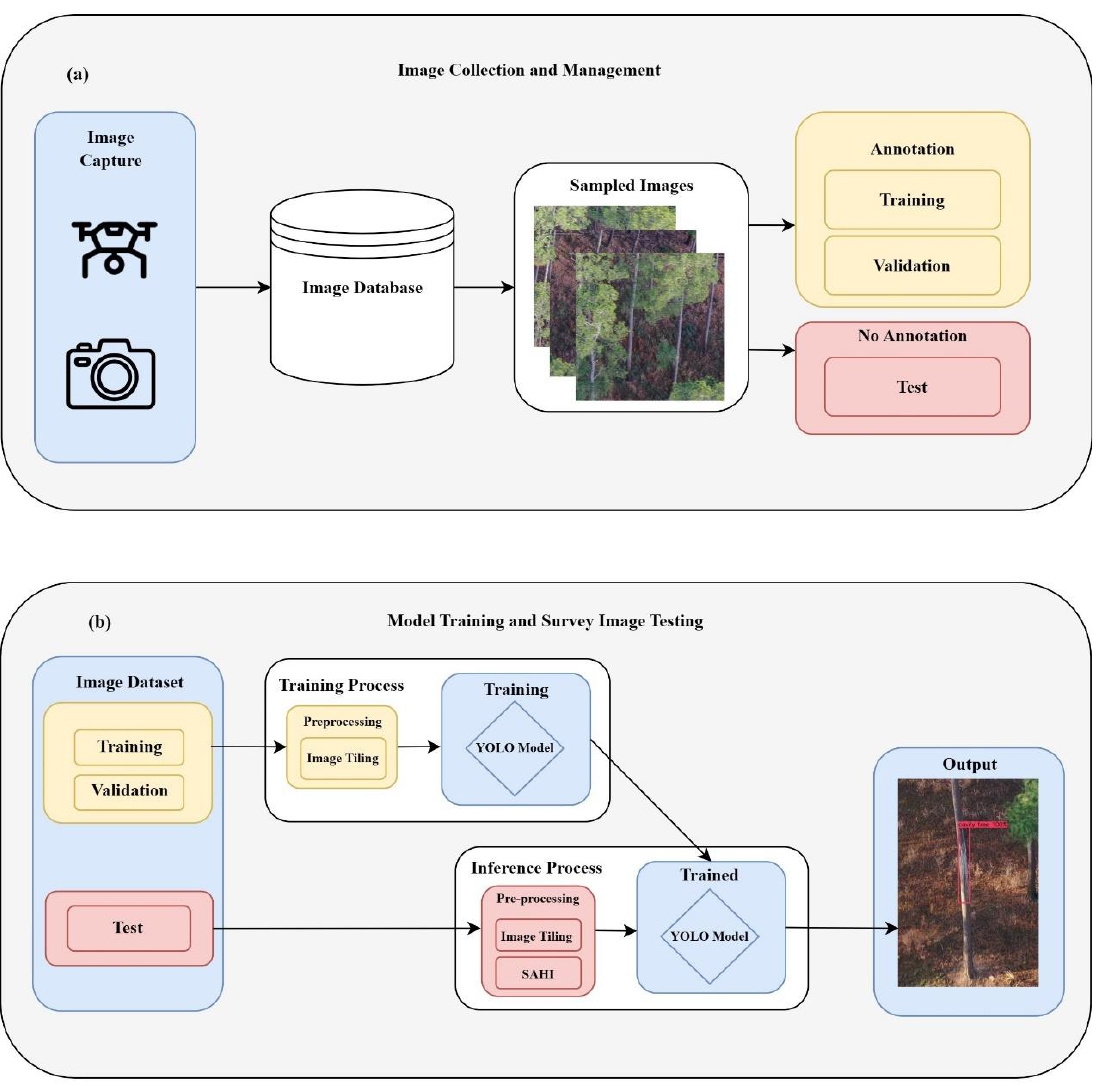
Figure 4. The entire workflow of our model development, which consists of ( a ) image collection and management and ( b ) model training and survey image testing. Both YOLOv4-tiny and YOLOv5n were used for model training because of their fast detection or inference times and to allow for comparisons between the two YOLO versions. Tiling was used for both the models for training, while tiling was used for YOLOv4-tiny and SAHI for YOLOv5n for model inferencing. However, YOLO models require specific input image sizes that are much smaller than our original, large-resolution parent images. Compressing parent images down to input dimensions would cause loss of pixels and diminish the details necessary to detect small objects. We circumvented this issue by dividing each original image into smaller tiles, each of which conformed to network input dimensions (Figure 5).